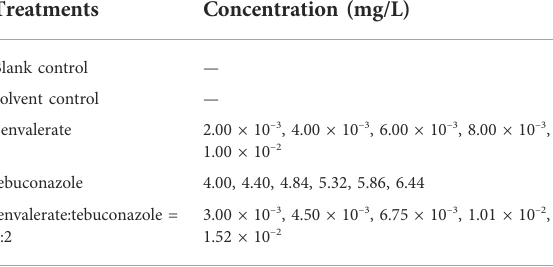
TABLE 2 Solution concentration for acute toxicity test in zebra fi sh larvae.